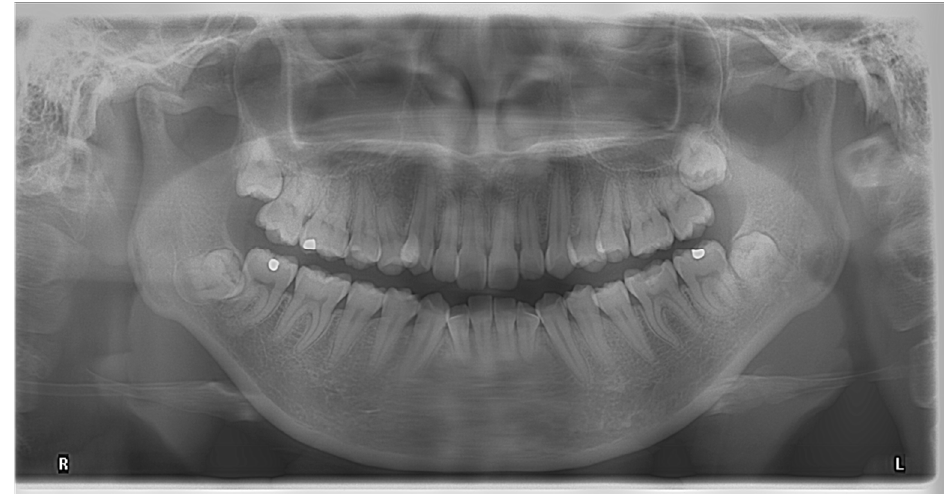
Figure 1. OPG showing the darkening of the root of a right lower third molar.